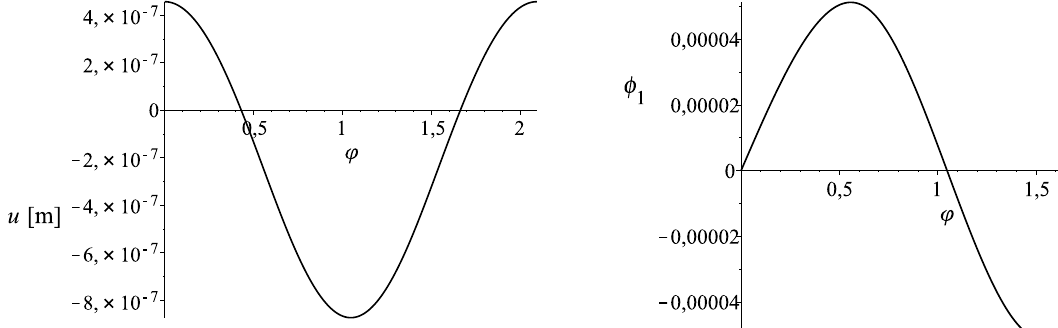
Figure 5: The graph of the radial displacement.